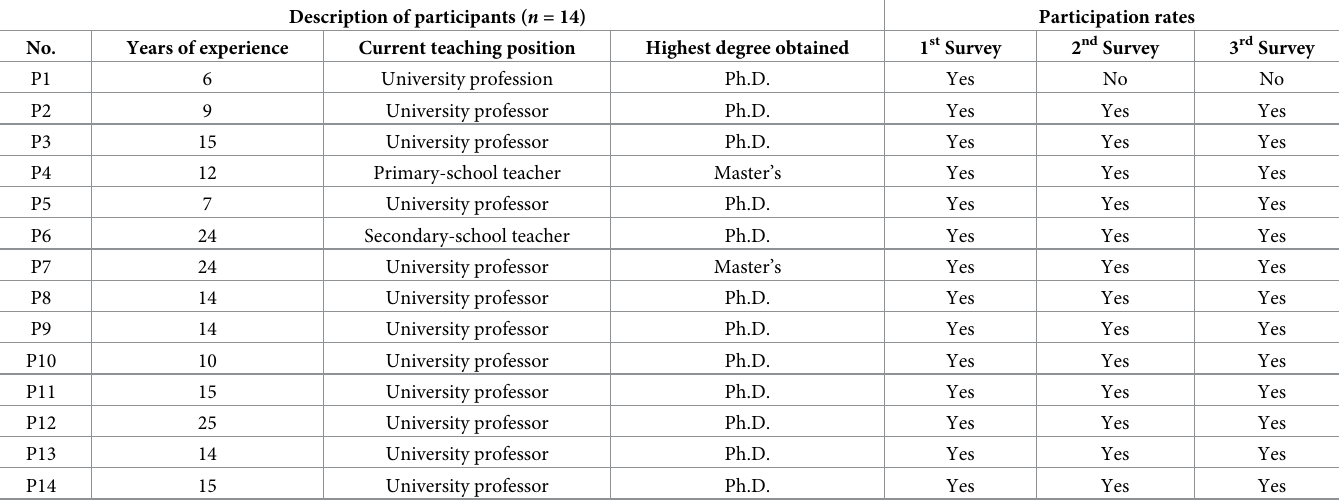
Table 1. List of